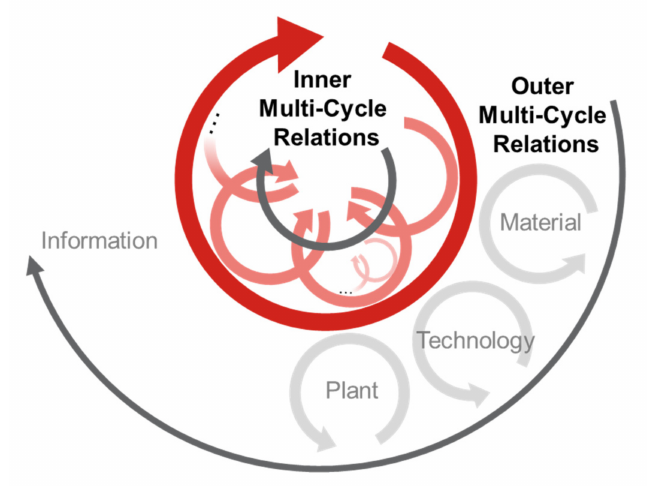
Figure 8. Inner and outer multi-cycle relations inter-linked by information flow.